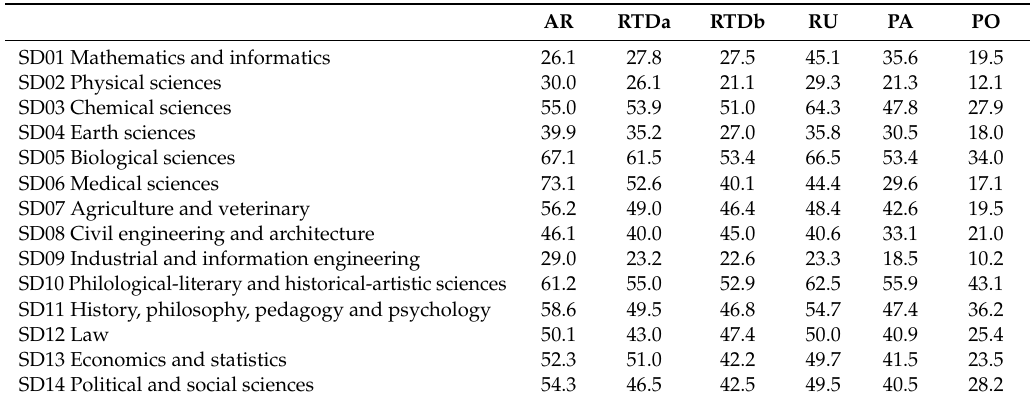
Table 5. Female % by rank and scientific field, stock, Italy,